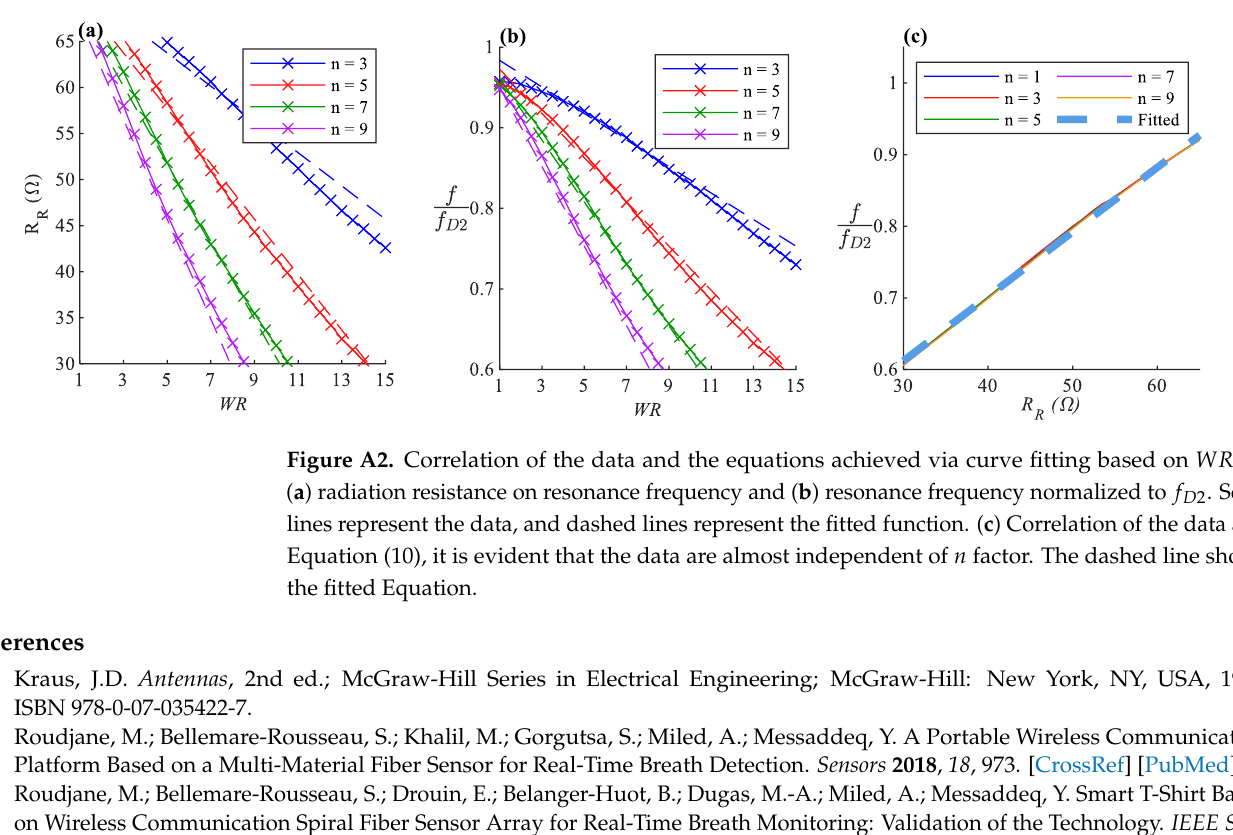
Figure A1. Correlation of the data and the equations achieved via curve fitting based on 𝑆𝑅 for ( a ) radiation resistance on resonance frequency (zoomed in) and ( b ) resonance frequency normalized to 𝑓 𝐷1 . Solid lines represent the data, and dashed lines represent the fitted function. It is clear that the fitted function on 𝑅 𝑅 is ambiguous for adjacent 𝑛 values.